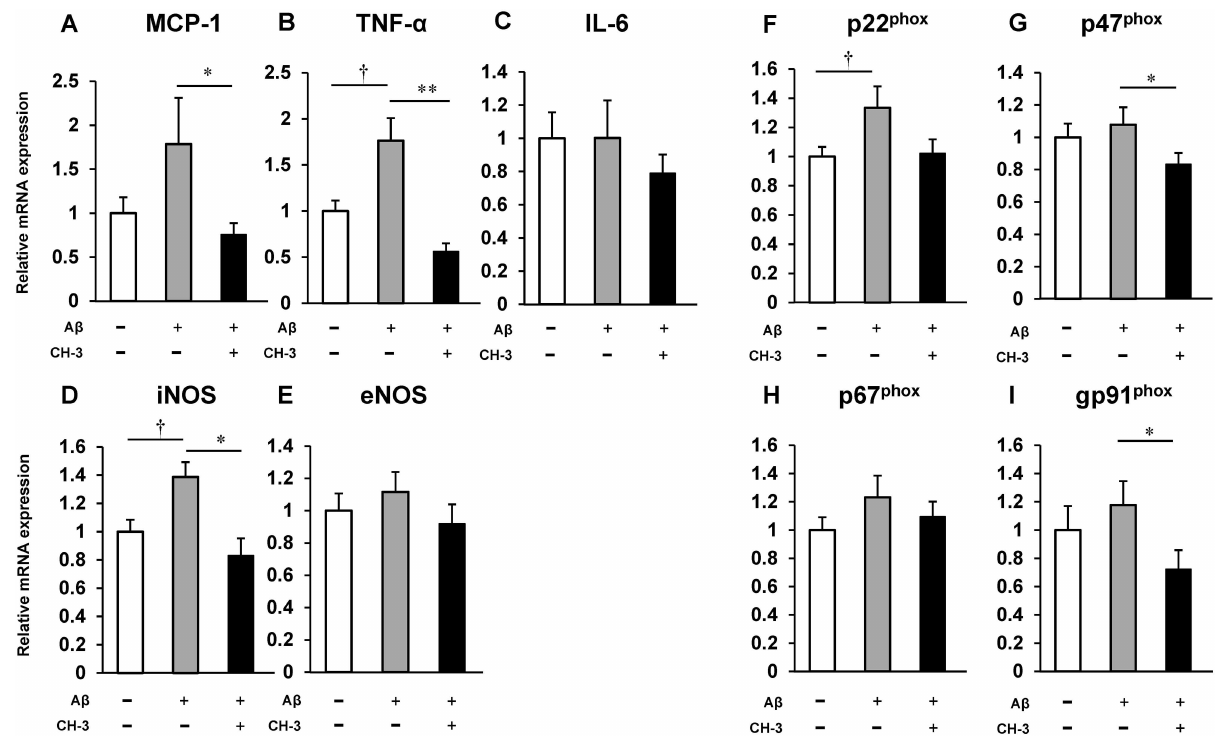
Fig 2. Change in mRNA expression of inflammatory cytokines and NADPHoxidase subunits in hippocampus of AD model mice by CH-3 treatment. mRNA expressionof MCP-1 ( A ), TNF- α ( B ), IL-6 ( C ), iNOS ( D ), eNOS ( E ), p22 phox ( F ), p47 phox ( G ), p67 phox ( H ) and gp91 phox (I) in hippocampus. n = 8–12mice in each group. † P < 0.05vs. control, * P < 0.05or ** P < 0.01vs. A β 1–42(+).